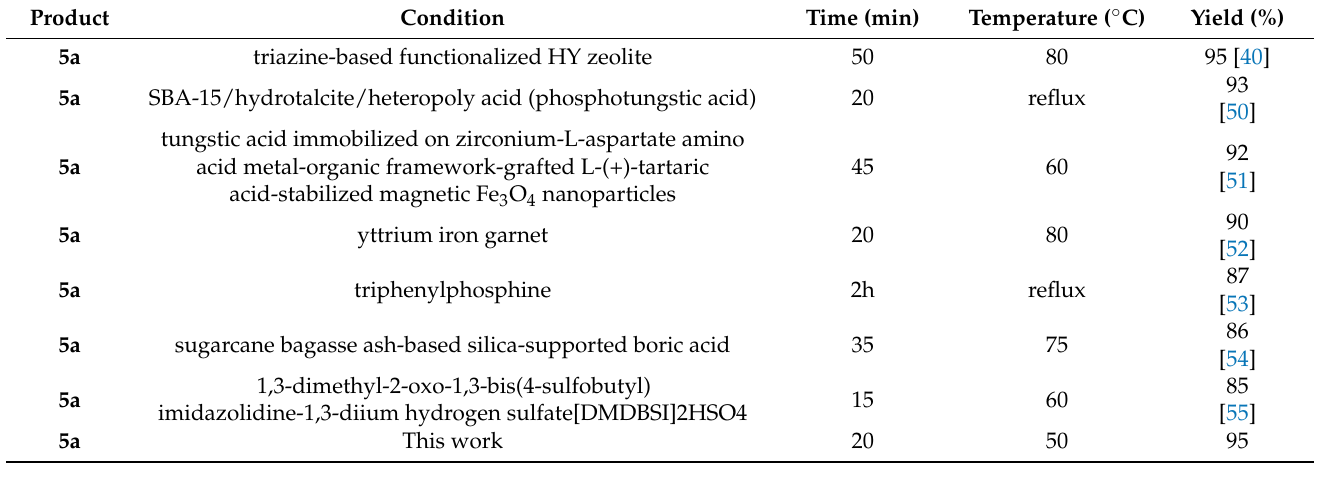
Table 3. Comparison of synthesis methods of 1,4-dihydropyrano[2,3-c]pyrazole-5-carbonitrile with the method studied in this research.